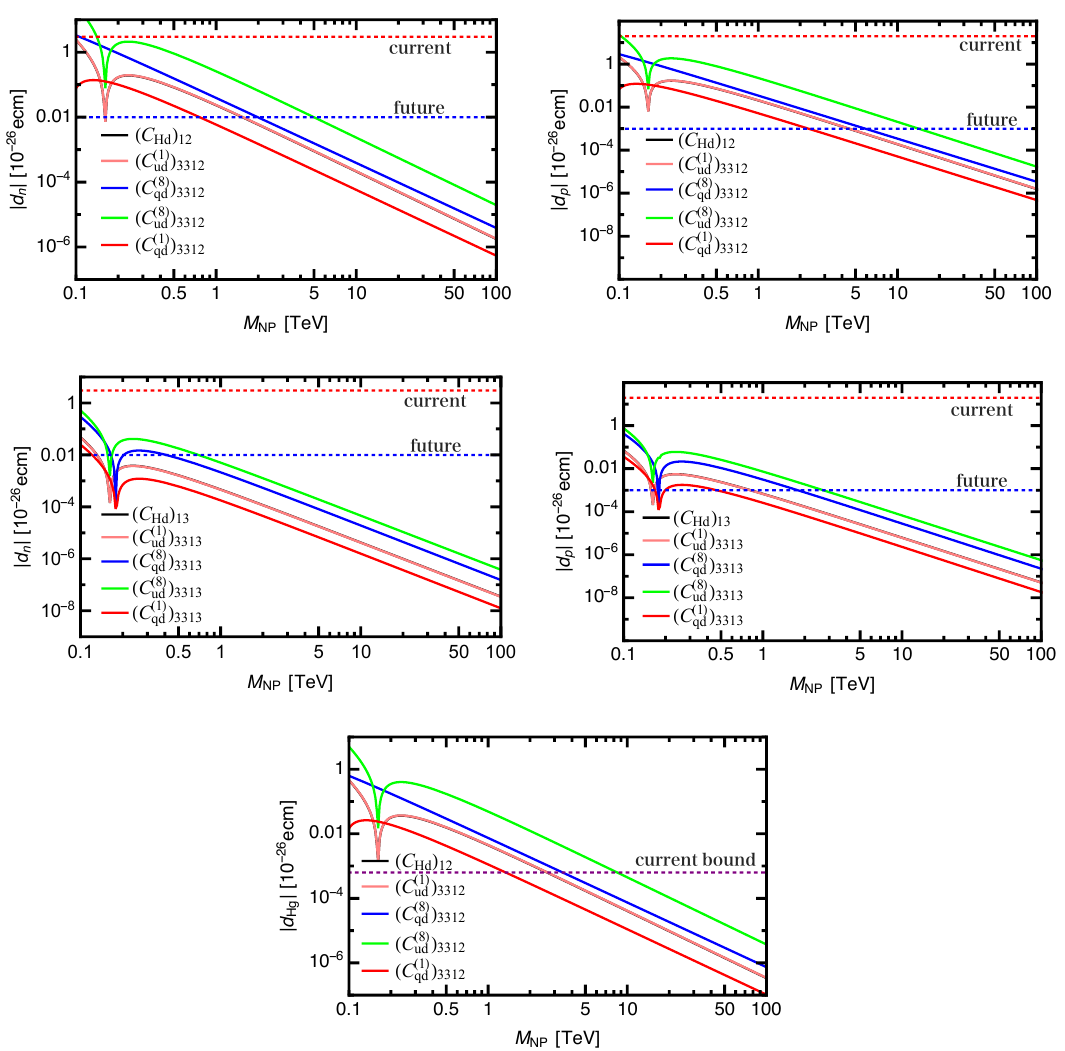
Figure 1 . The neutron and proton EDMs are estimated for the SMEFT (cid:1) F = 1 operators of the down and strange quarks with the top quarks in the top panels. Those for the down and bottom quarks are shown in the middle panels. The red and blue dotted lines are the current experimental limit and the future sensitivity. Also, the 199 Hg EDM for the down and strange quarks are in the bottom panel. The purple dotted line is the current experimental limit. The Wilson coe(cid:14)cients are i=M 2 at the NP scale M NP NP